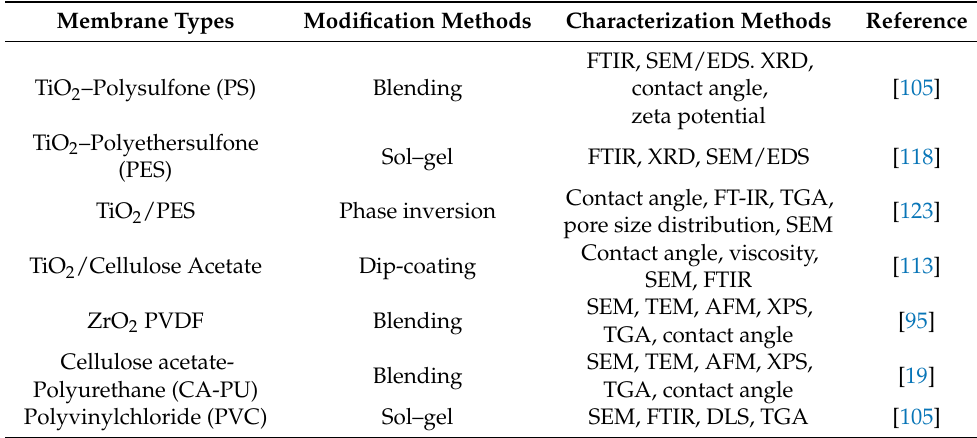
Table 8. Modification and characterization techniques of TiO 2 -based membranes.